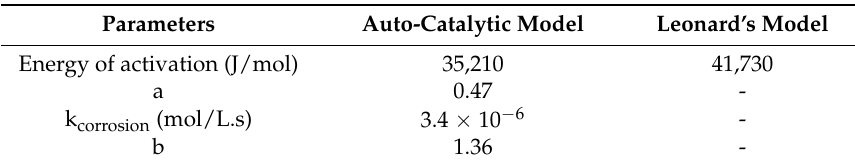
Table 3. Optimised parameters for auto-catalytic kinetics.